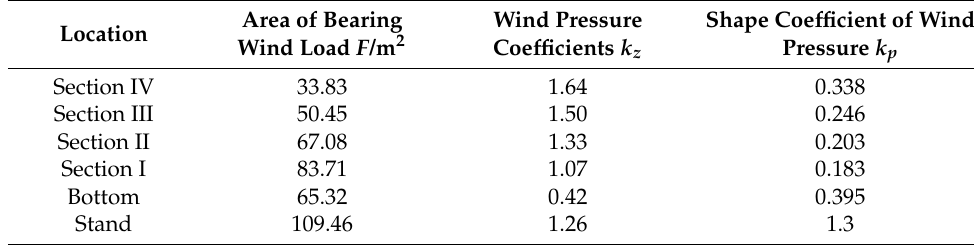
Table 1. Value of coefficients and area of bearing wind